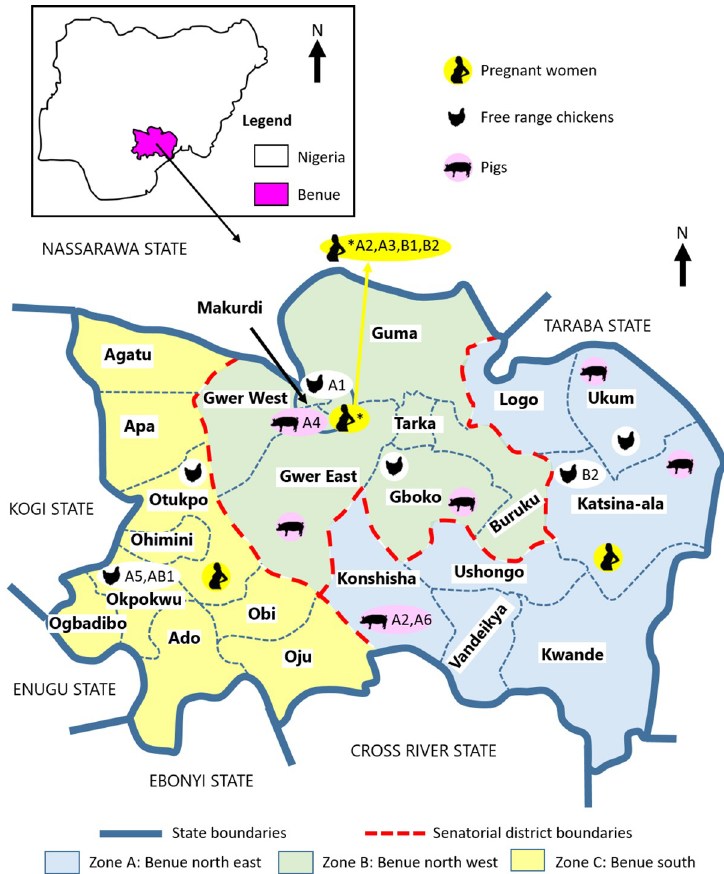
Fig 4. Sample sites and Toxoplasma gondii haplotype occurrence within Local Government Areas (LGAs) in Benue state, Nigeria. LGAs sampled are shown, grouped into Zones A (Katsina-Ala, Konshisha, Ukum), B (Gboko, Gwer East, Markurdi) and C (Okpokwu, Oturkpo). The distribution of haplotypes A1-6, B1-2 and AB1 annotated in Fig 3. is indicated. (Map redrawn here based upon resources accessed from